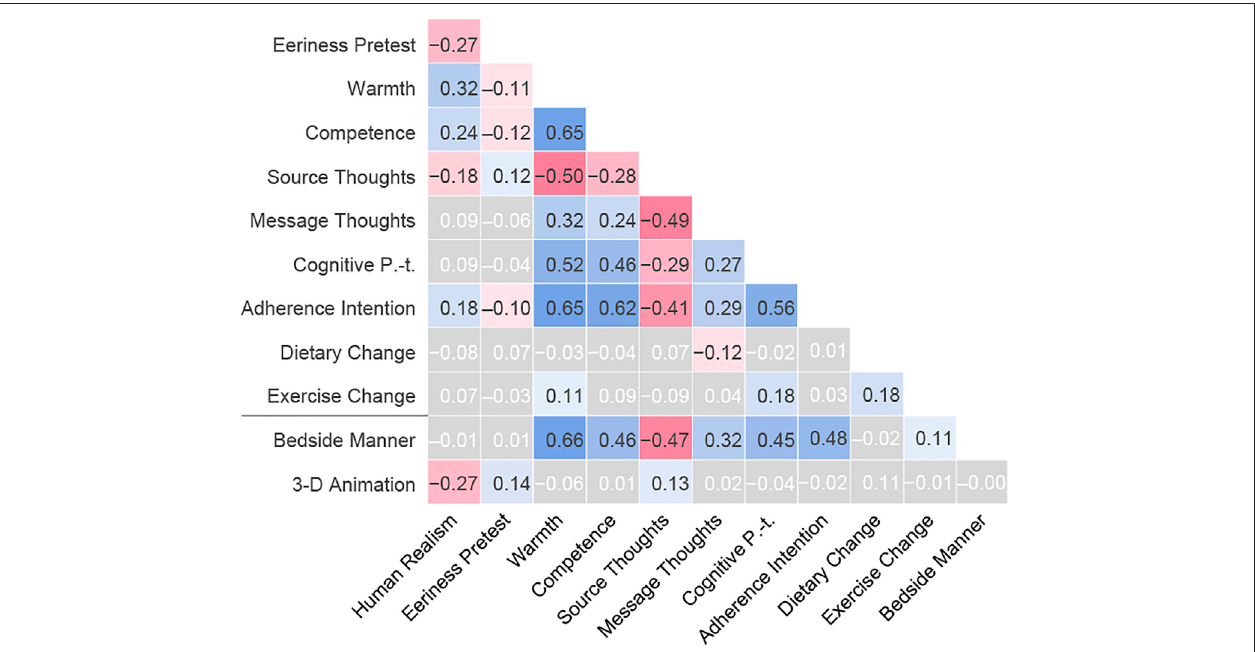
FIGURE 2 | Pearson ’ s correlation between the dependent and independent variables. All correlations were signi fi cant except those indicated by white text on a gray background.